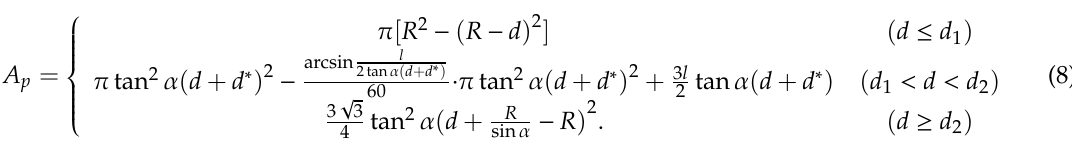
Figure 1. Dimension parameters and geometric shape of the Berkovich indenter: ( a ) model diagram, ( b ) top view, ( c ) side view, and ( d ) 3-D solid model.